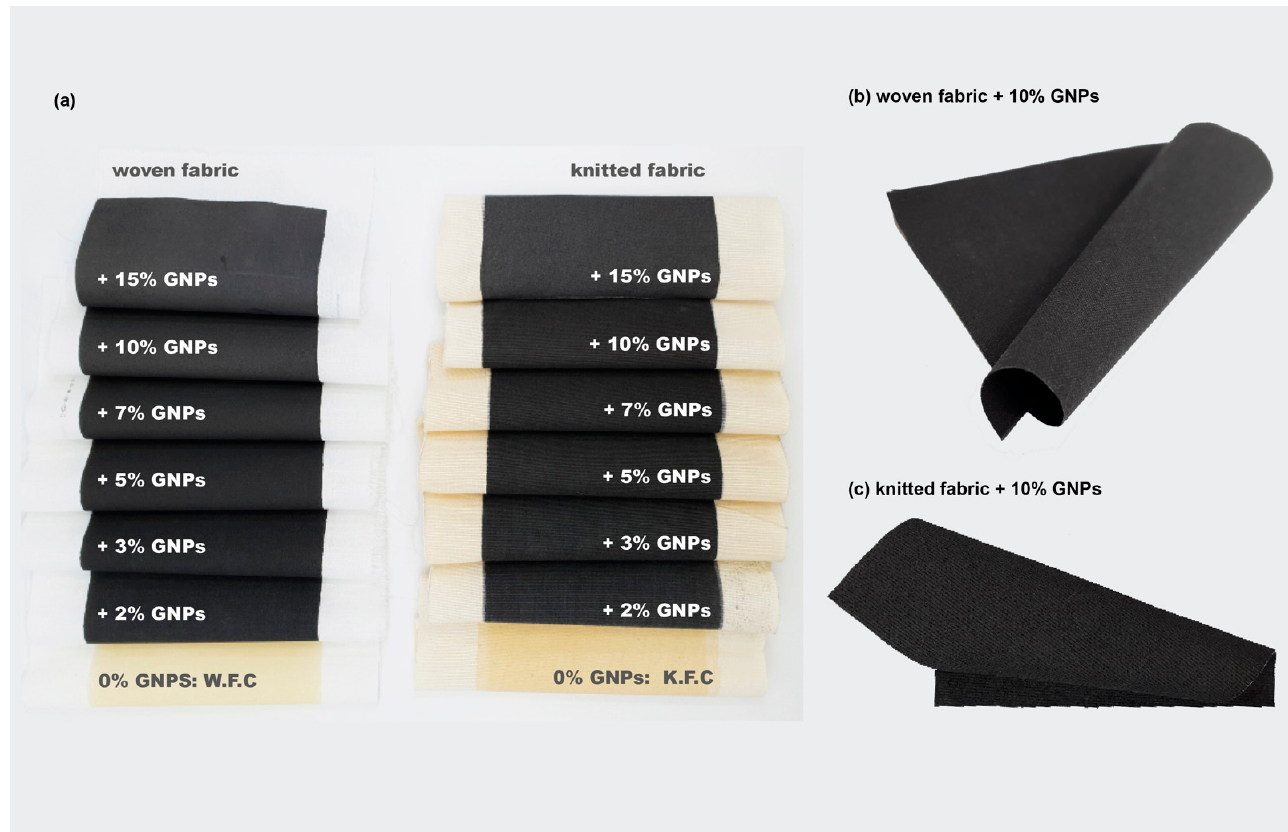
Figure 5. ( a ) Samples functionalised with different % of GNP and the control samples, in woven and knitted fabrics; ( b ) woven fabric functionalised with 10% GNP; ( c ) knitted fabric with 10% GNP.